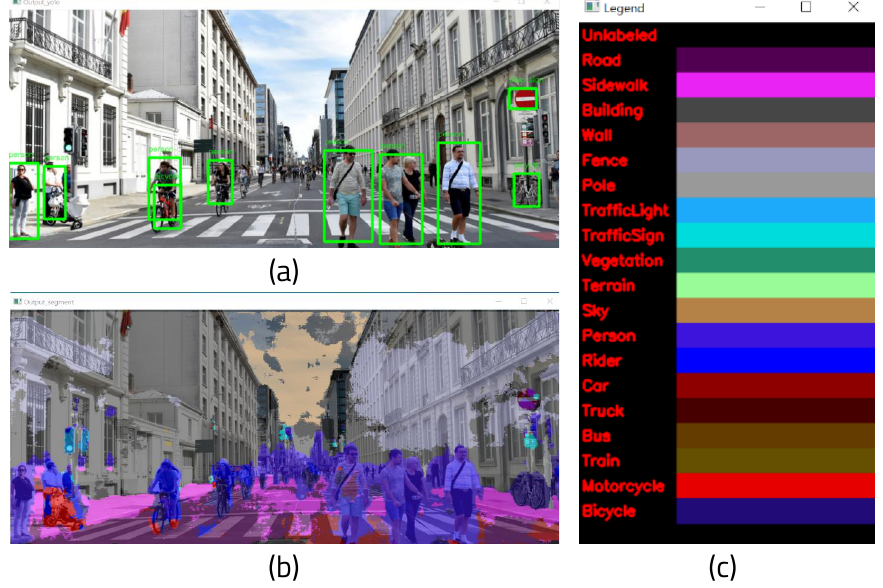
Figure 2. ( a ) Result of YOLO object detection, ( b ) result of semantic segmentation, and ( c ) classes and labels of semantic